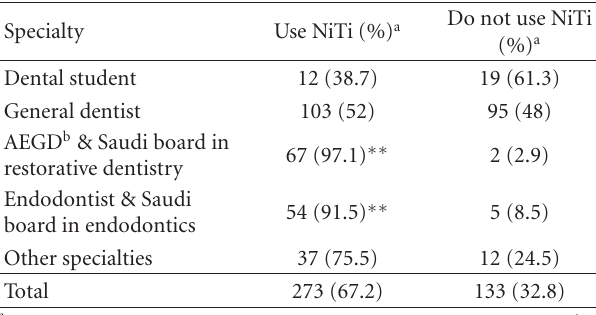
Table 2: Response details for NTRF usage according to specialty.